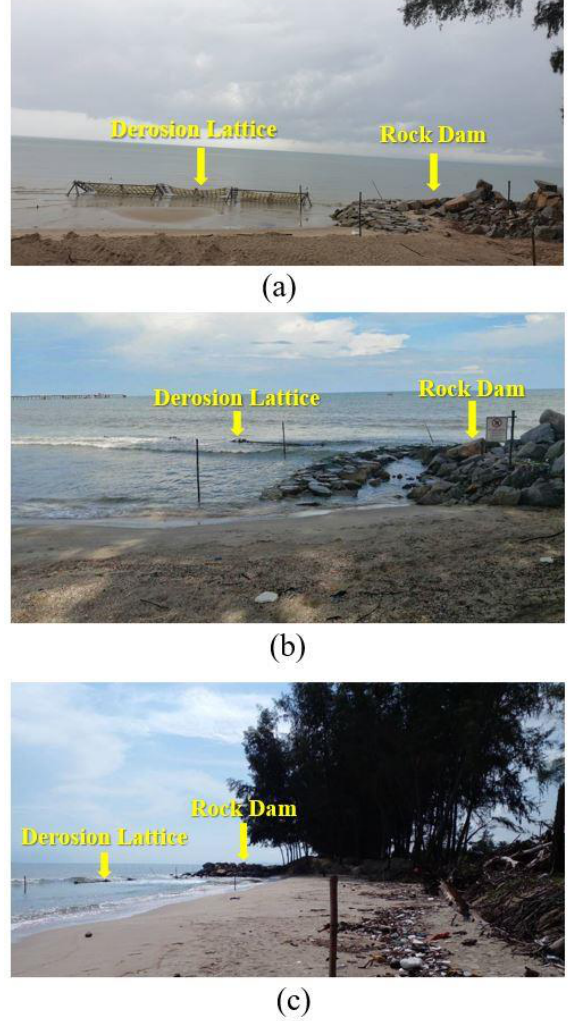
Figure 17. The installation outcomes: ( a ) the first day of installation, ( b ) viewed from the back, and ( c ) viewed from the side, two months later after installation.